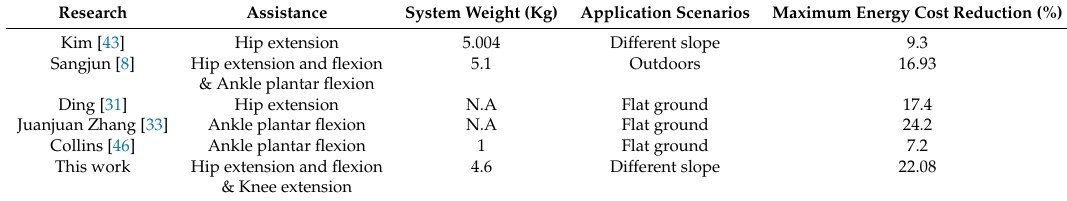
Table 4. Comparison with popular soft exoskeletons. Where N.A. means that the the system is not